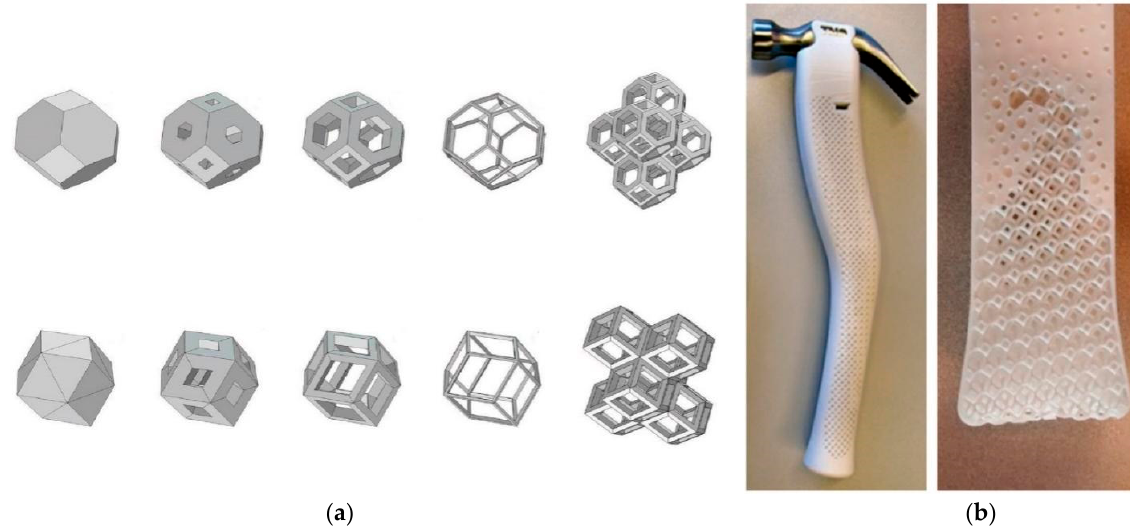
Figure 23. ( a ) Rhombic dodecahedron (top) and truncated octahedron (bottom) with the density grading (100%, 60%, 30%, and 10%). In both subplots, the image on the far right demonstrates how the polyhedrons perfectly tessellate [18]; ( b ) The optimized hammer handle that was constituted of 3 different density grading cells [63].